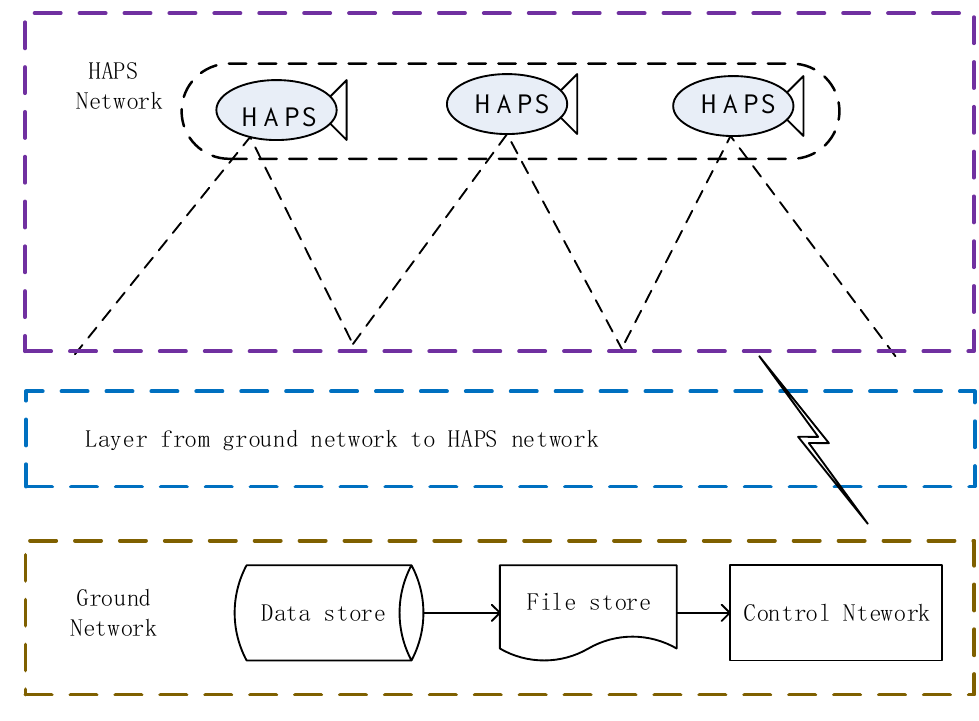
Figure 1. System frame diagram of the High Altitude Platform Station (HAPS).